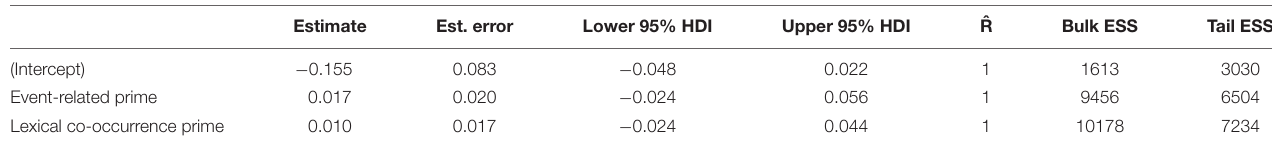
TABLE 9 | Model 4 primed naming response time population-level effects for participants with